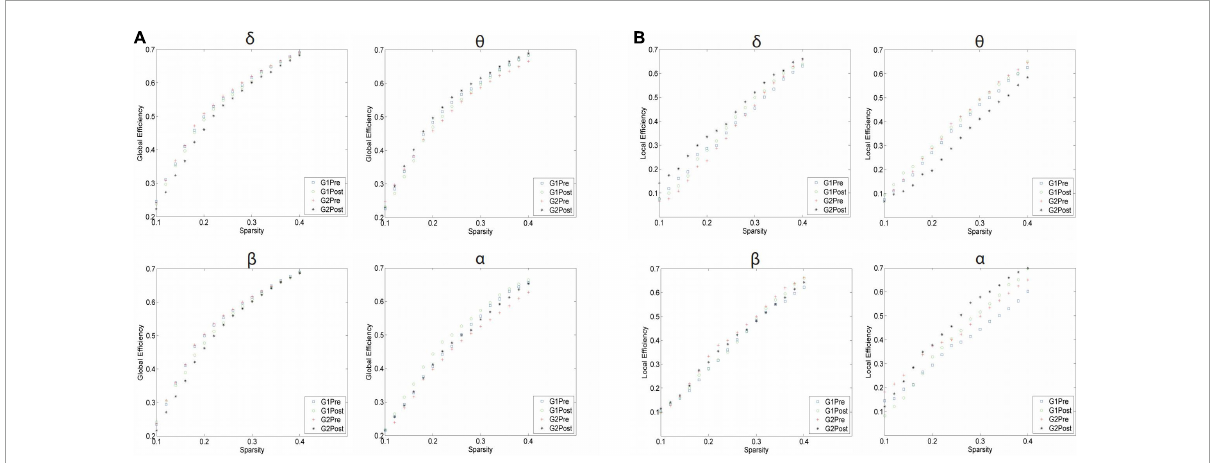
FIGURE4 Difference of topological parameters of global efficiency between Qigong group and control group in (A) Delta band; Theta band; Beta band; and Alpha band before and after treatment. The sparsity was set as 0–80%. Delta band: δ ; Theta band: θ ; Beta band: β ; and Alpha band: α . Difference of topological parameters of local efficiency (LE) between Qigong group and control group in (B) Delta band δ , Theta band θ , Beta band β , and Alpha band α before and after treatment. The sparsity was set as 0–80%.